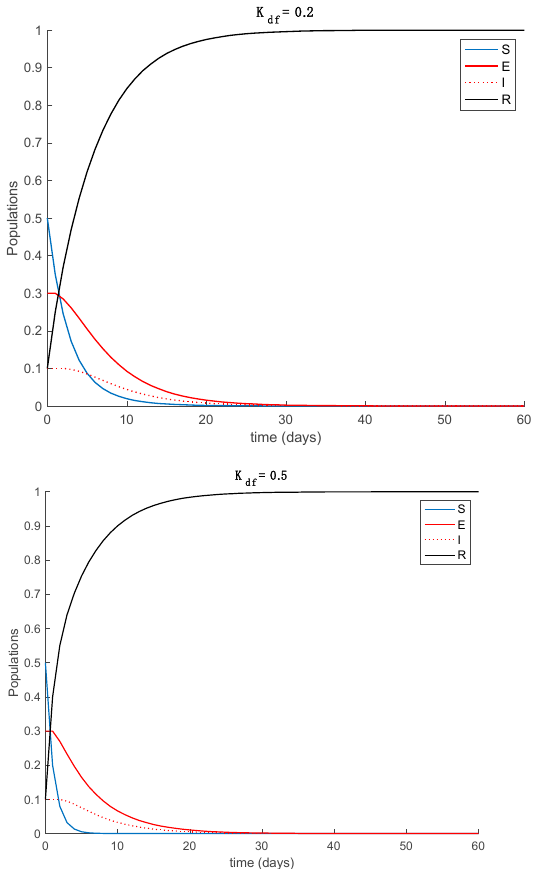
1 = R in both cases, as Prop- df K df = 0.9901, in accordance A + K df